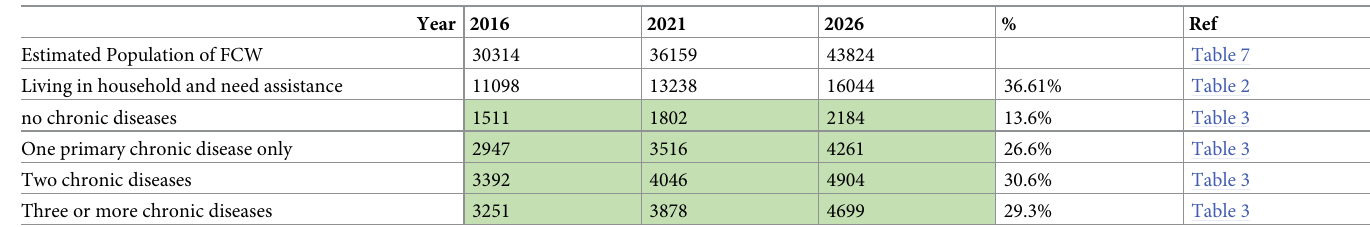
Table 8. Estimated population of FCW with different numbers of chronic diseases. Estimated Population of FCW Living in household and need assistance no chronic diseases One primary chronic disease only Two chronic diseases Three or more chronic diseases